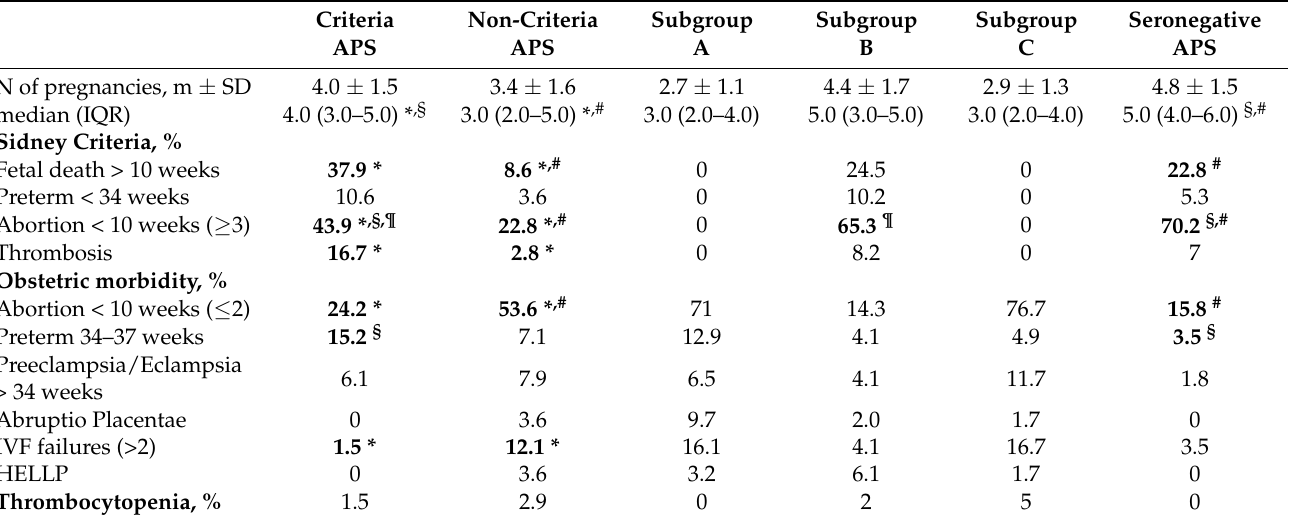
Table 6. Clinical APS subgroups according to the Sydney criteria, obstetric morbidity related to APS, Table 7. Obstetric outcome and main obstetric complications in the different groups according to and thrombocytopenia in the different study groups. treatment. Criteria Non ‐ Criteria Subgroup Subgroup APS APS